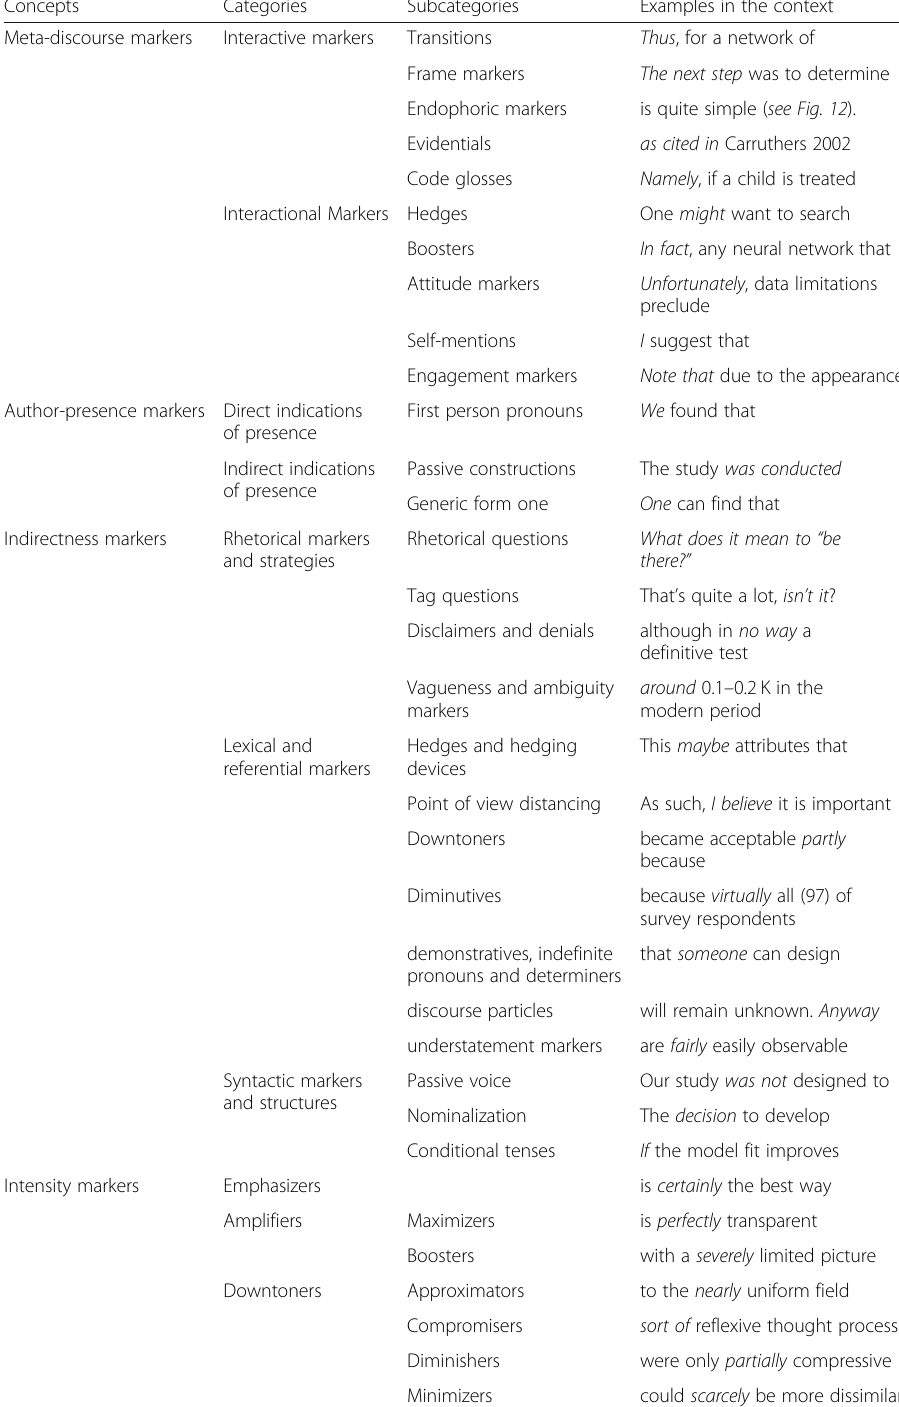
Table 5 Meta-discourse Markers Based on Meta-synthesis Concepts Categories Meta-discourse